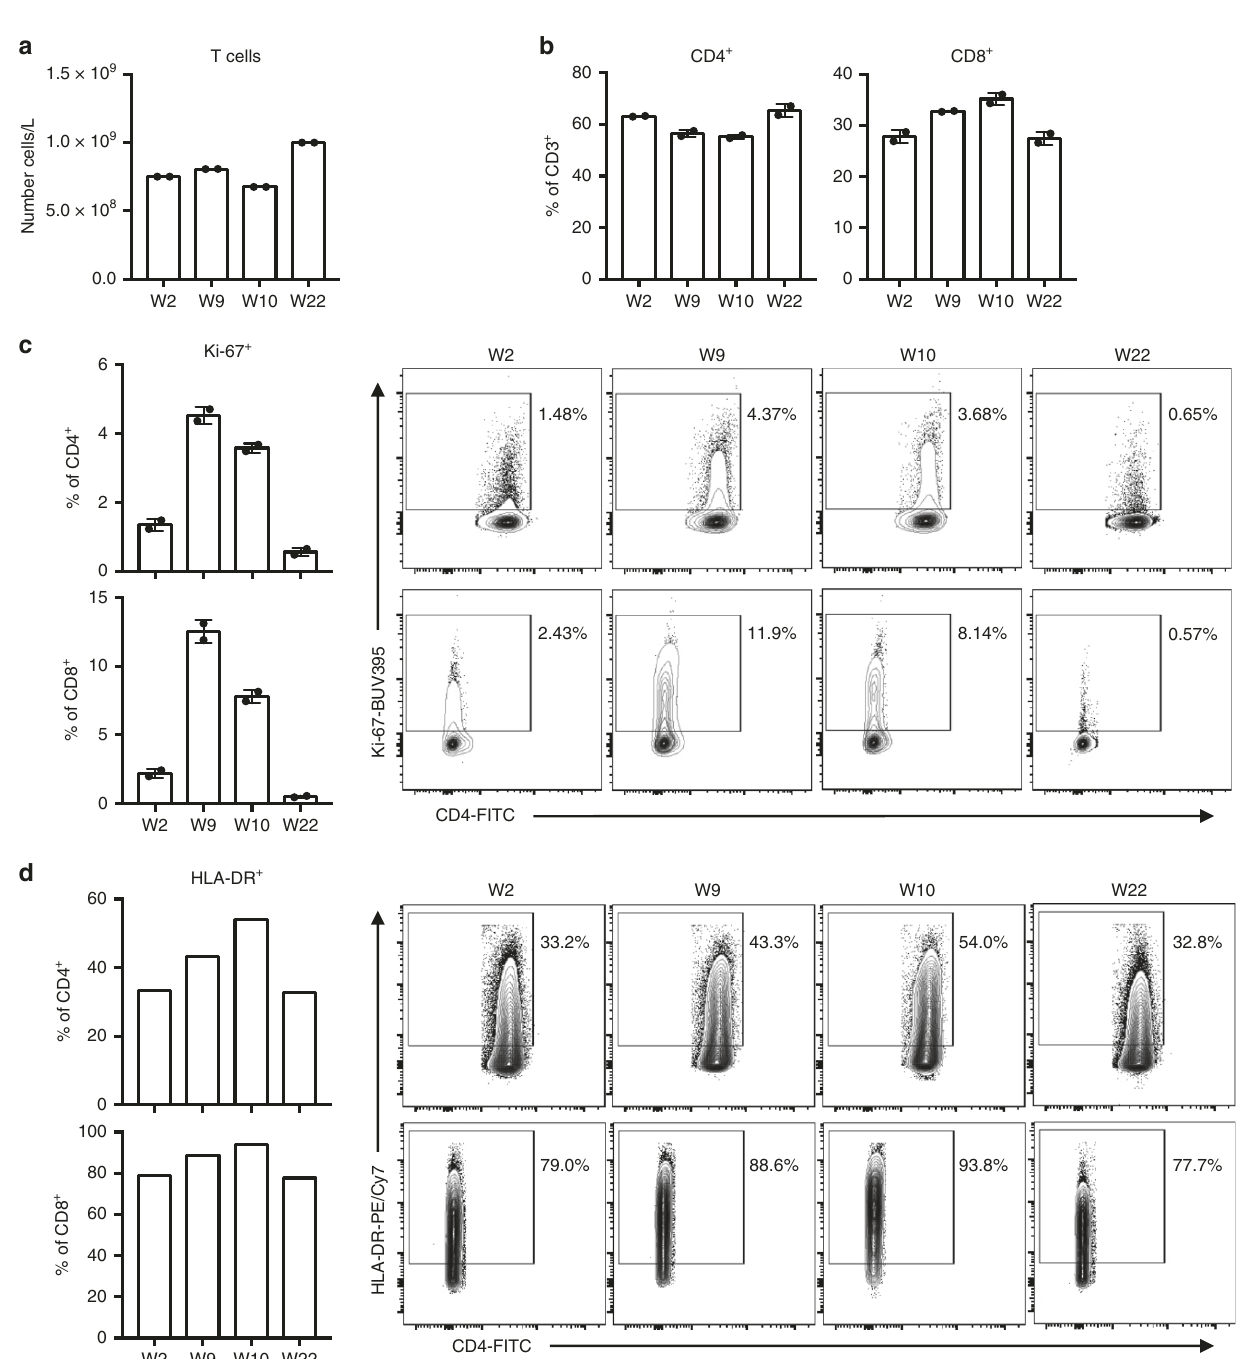
Fig. 1 T cell activation during allograft loss is ameliorated with ICI-mTORi combination. Peripheral blood mononuclear cells (PBMC) were isolated from the melanoma patient before pembrolizumab therapy and renal transplant rejection (W2), during renal transplant rejection when following two cycles of pembrolizumab therapy (W9), at the height of renal transplant rejection when prednisone therapy was started and pembrolizumab halted (W10), and fi nally when rejection was resolved, prednisone tapered away and the patient was placed on pembrolizumab and sirolimus combination therapy (W22). PBMC were stained for fl ow cytometric analysis of various T cells populations. a Total T (CD3 + ) cell numbers in PBMC as determined by fl ow cytometry are plotted. b Proportions of CD4 + and CD8 + T cells are shown. c , d Proportions of cycling (Ki-67 + ) and activated (HLA-DR + ) cells of CD4 + or CD8 + T cells are shown with the representative fl ow cytometry plots on the right. a – c were completed in duplicates, mean ± SD are shown. d was completed